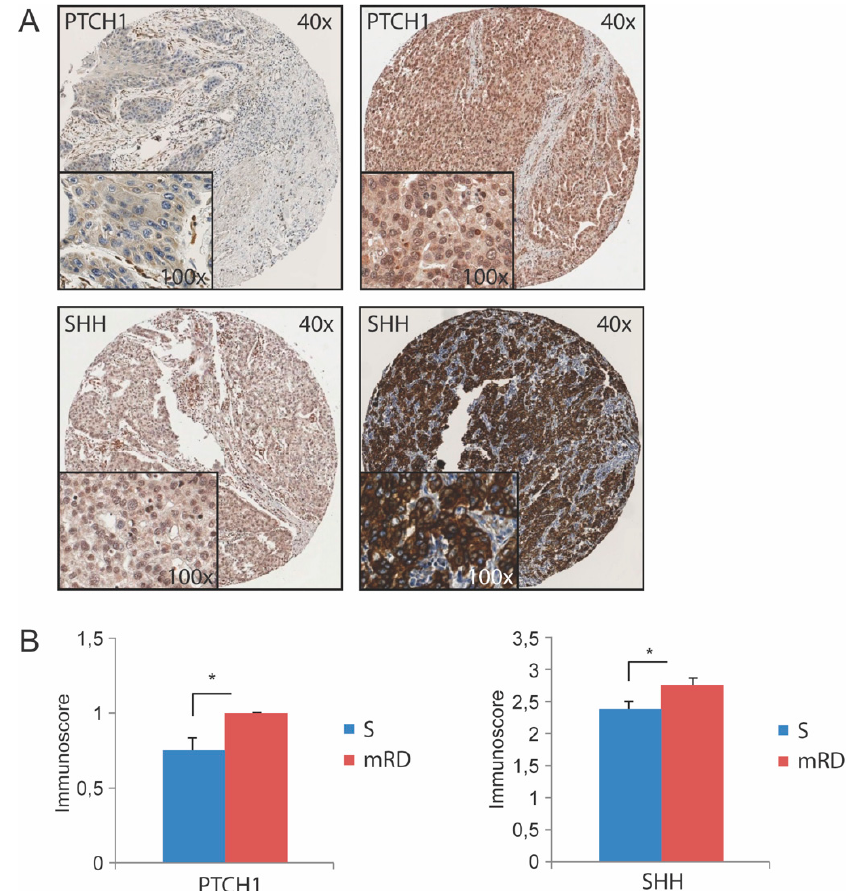
Figure 1. PTCH1 and SHH are up-regulated in mRD patients compared to surgery alone patients (S). ( A ) Representative samples of low intensity PTCH1 and weakly positive SHH expression (respectively upper left and lower left), and high intensity PTCH1 and strong positive SHH expression (respectively upper right and lower right). ( B ) Comparison of PTCH1 ( p = 0.04) and SHH ( p = 0.04) IHC expression between mRD after neoadjuvant CRT resection specimens ( N = 16) and S specimens ( N = 32). Error bars represent standard error of the mean (SEM), * p < 0.05.